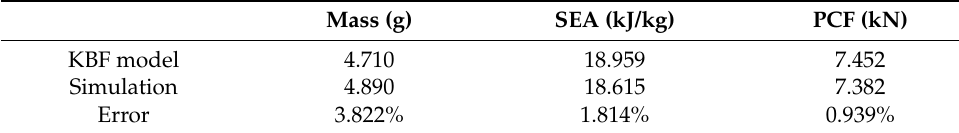
Table 10. Comparison between simulation and KBF model of optimum point.